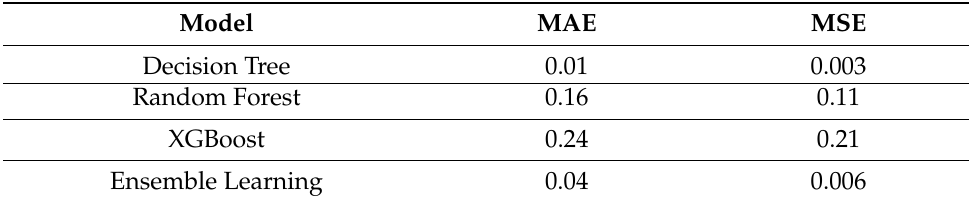
Table 7. Performance metrics of regression